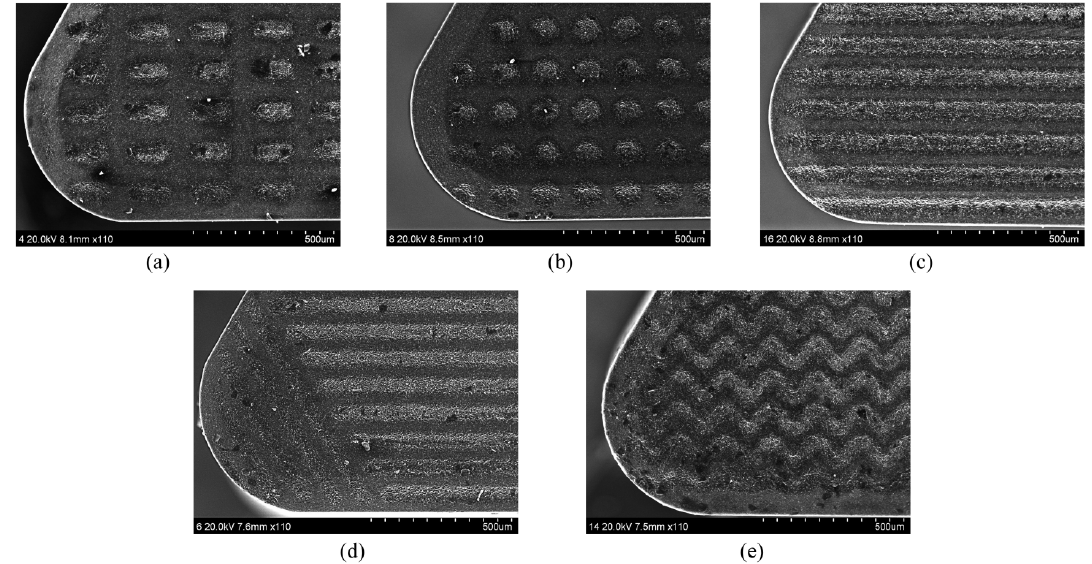
Figure 22. SEM images of five types of micro-textured tools: ( a ) circular pits; ( b ) elliptical grooves; ( c ) transverse grooves; ( d ) composite grooves; ( e ) wavy grooves [82].